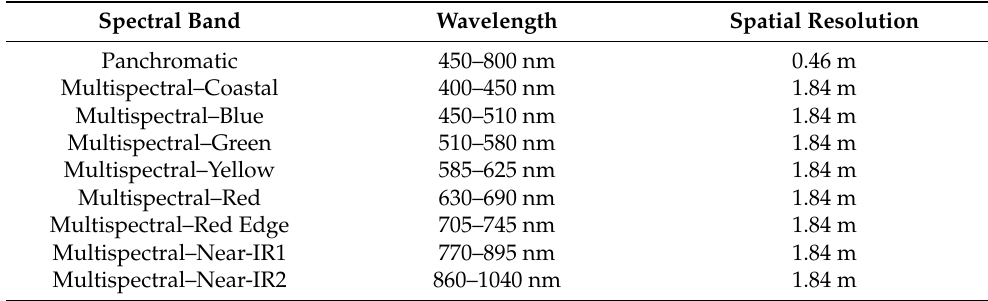
Table 1. Band characteristics of WorldView-2 imagery